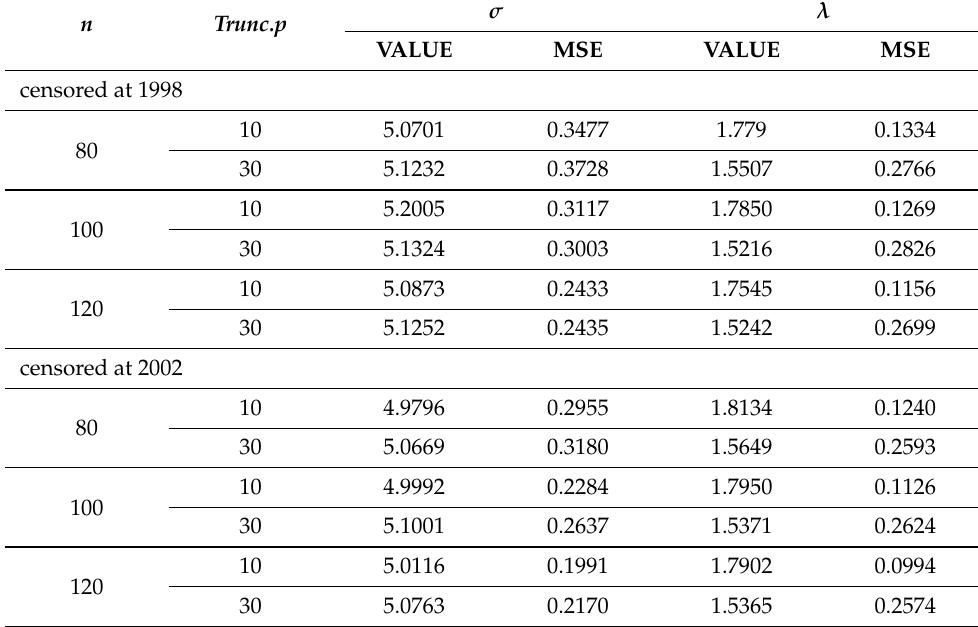
Table 1. The simulation results of MLEs for σ and λ